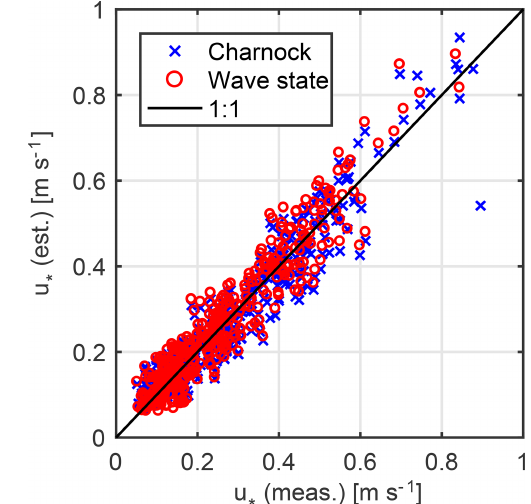
Figure 8. Estimated and measured momentum fluxes (friction ve- locities) using constant Charnock-coefficient (blue crosses) and wave age based roughness length parameterization (red circles).